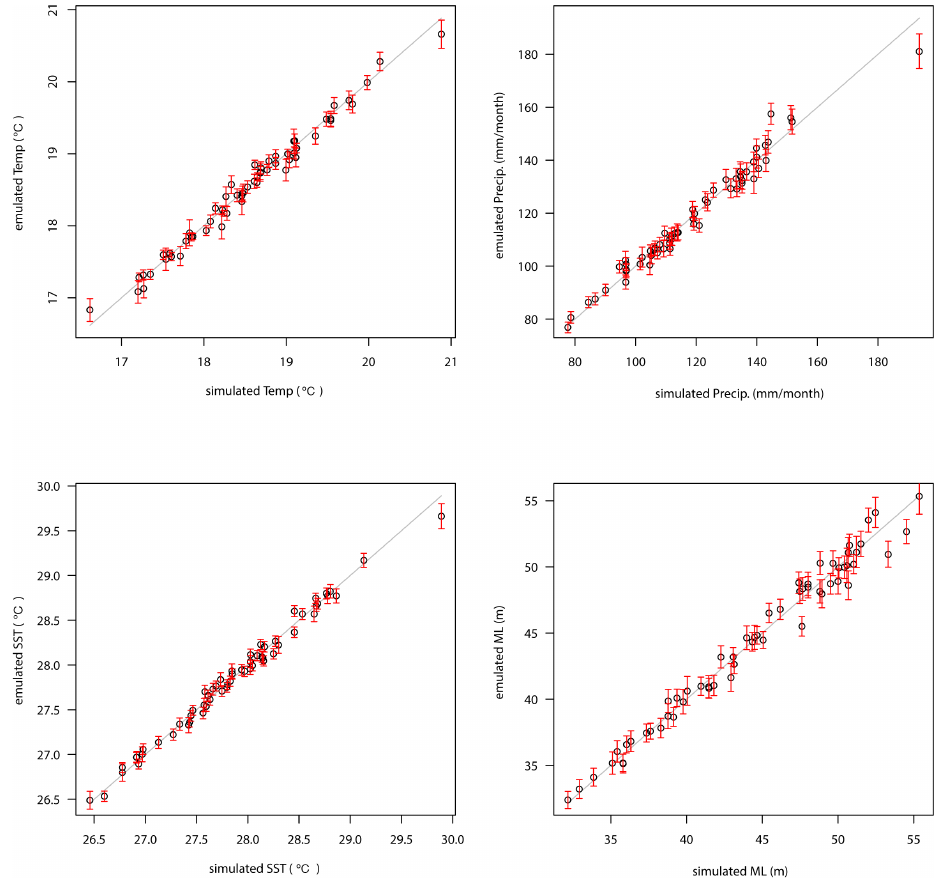
Figure 8. Diagnostic of emulator performance. Shown are the mean and standard deviation of the simulated and the emulated data points for the all the simulations with the exception of simulation number 11 and 40. Top left panel: continental temperature; top right panel: continental precipitation; bottom left panel: sea-surface temperature; bottom right panel: mixed-layer